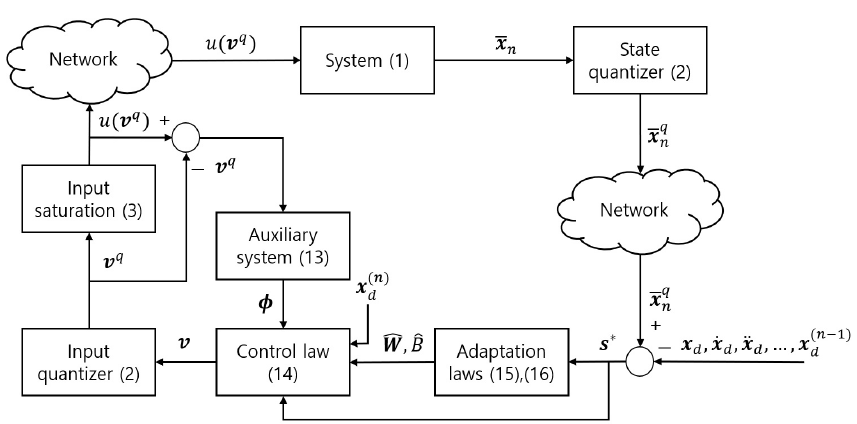
Figure 1. Block diagram of the proposed quantized-states-based adaptive tracking system in the presence of quantized input